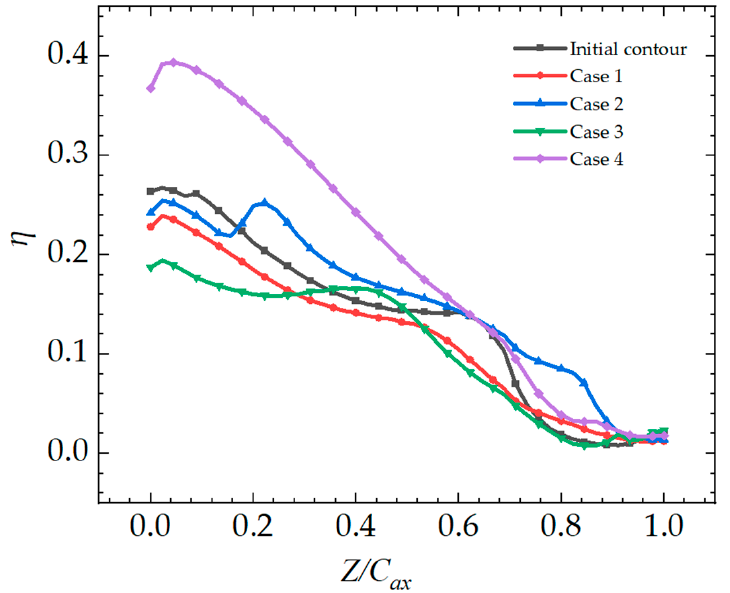
Figure 11. Axial distributions of laterally averaged film effectiveness on the